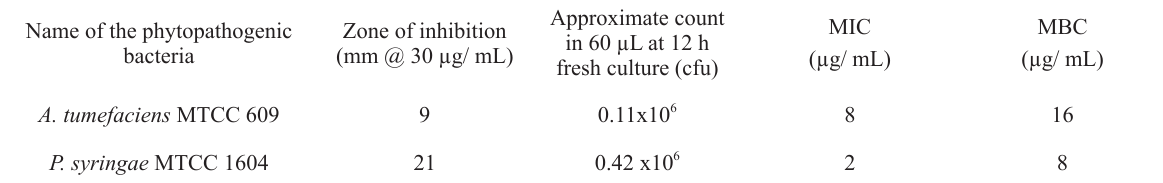
Antiphytopathogenic activity of the isolate